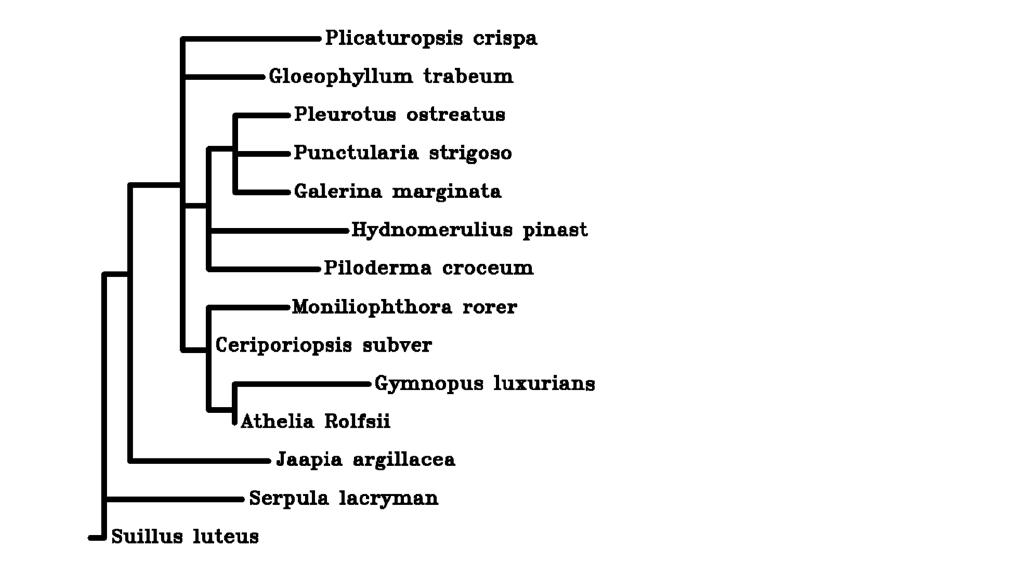
Figure 8. Phylogenetic tree showing the phylogenetic relationship amongst different fungal genomes belonging to class